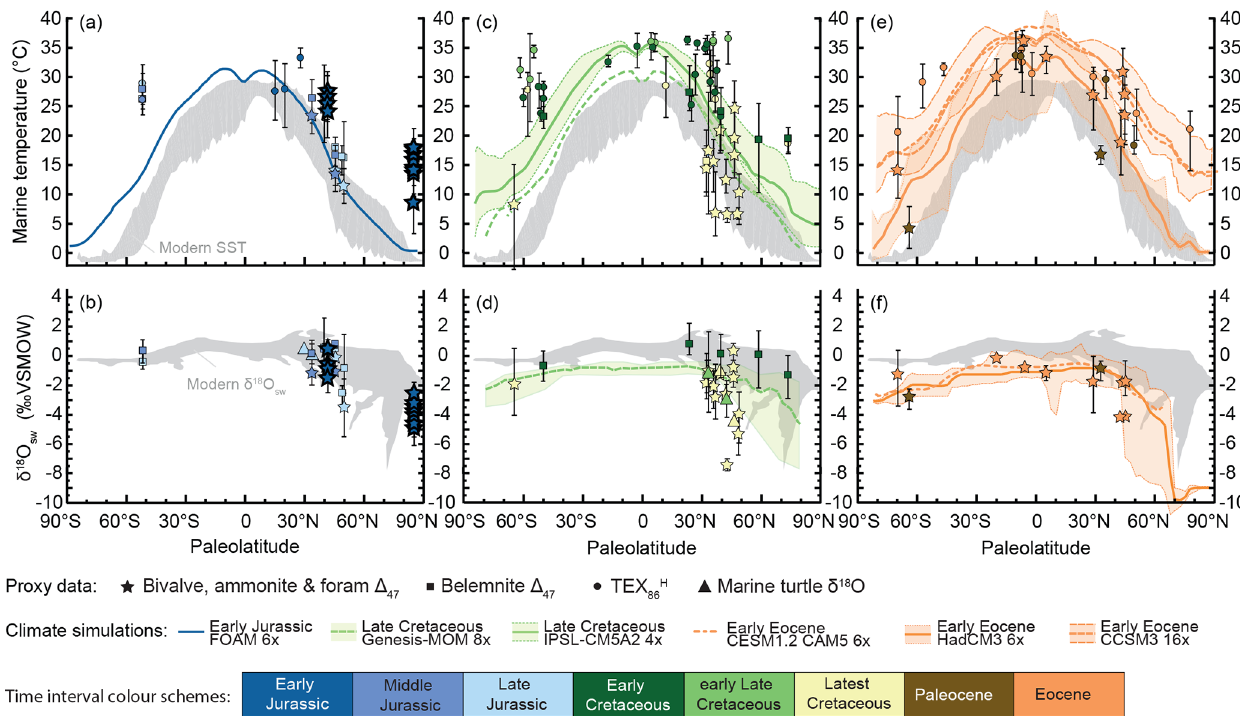
Figure 5. Comparison of the new (bold outline) reconstructed Early Jurassic SST and δ 18 O sw with published Jurassic–Eocene proxy-based reconstructions (thin outline) and Earth system simulations. Proxy–model comparisons of SST and δ 18 O sw are shown for the Jurassic (a,b) , the Cretaceous (c,d) , and the early Paleogene (e,f) . Proxy data are divided between eight time slices based on their definition in the Interna- tional Chronostratigraphic Chart v2020/03 (Cohen et al., 2013; updated); early Late Cretaceous: Cenomanian to Santonian; latest Cretaceous: Campanian–Maastrichtian. Marker colour shows sample age accordingly (see key). New data are displayed as the reported value and its as- sociated uncertainties for each samples. Datasets from the literature, from the same proxy and location, were regrouped within each time slice. The marker displays the mean of available data and the error bar the extent of the data (minimal to maximal value). Both (cid:49) 47 and TEX H temperatures are published temperatures. δ 18 O w values were recomputed using published (cid:49) 47 temperatures and δ 18 O c with the fol- 86 lowing fractionation equations – belemnite calcite: Coplen, (2007), aragonite: Grossman and Ku(1986), bivalve calcite: Epstein et al. (1953), foraminifera: Erez and Luz (1983), turtle bones: Barrick et al. (1999), updated by Pouech et al. (2014). Results of Earth system simulations from the literature are shown as annual averages (bold lines) and summer and winter seasonal averages (colour shading). Modern ranges of SST and δ 18 O sw are also shown (grey shading) for comparison. (cid:49) 47 data are from the following: Keating-Bitonti et al., 2011;